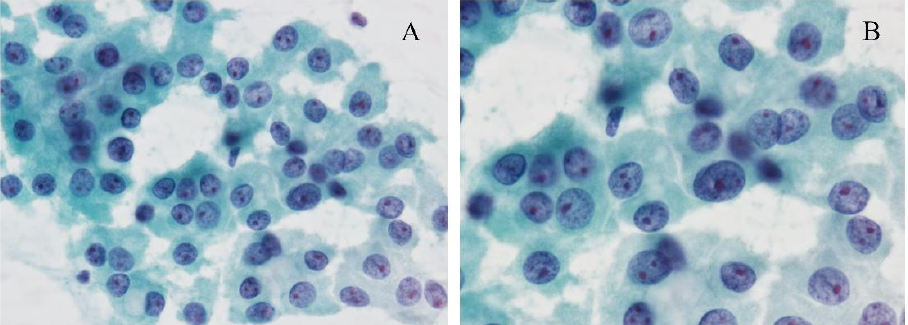
Figure 1. Cytological images of the Hürthle cell carcinoma (HCC). ( A ) The Papanicolaou-stained smear shows a monotonous cells oncocytic cells with prominent nucleoli arranged in loosely cohesive clusters. Papanicolaou stain, original magnification × 200. ( B ) The cells have prominent nucleoli, bland chromatin, and granular cytoplasm. Papanicolaou stain, original magnification × 600. Oncocytic cells are also observed in nodular goiter, chronic thyroiditis, and oncocytic variants of papillary thyroid carcinoma and oncocytic variant of medullary thyroid carci- noma (OV-MTC). Therefore, the presence of these cells should not engender a diagnosis of Hürthle cell lesion [5]. In chronic thyroiditis and nodular goiter, isolated or small cohesive clusters of oncocytic cells are common, representing follicular cells with oncocytic metaplasia. In addition, in nodular goiter, follicular cells with abundant colloids are ob- served, and the follicles are not uniform. In chronic thyroiditis, lymphoplasmacytic infil- trations are frequently observed. However, when a large irregular sheet of oncocytic cells dominantly appear, differentiating between chronic thyroiditis and Hürthle cell tumor may be difficult. Indicators of true Hürthle cell tumors are (1) microfollicular architecture, (2) absence of colloid, (3) absence of inflammation, and (4) presence of transgressing blood